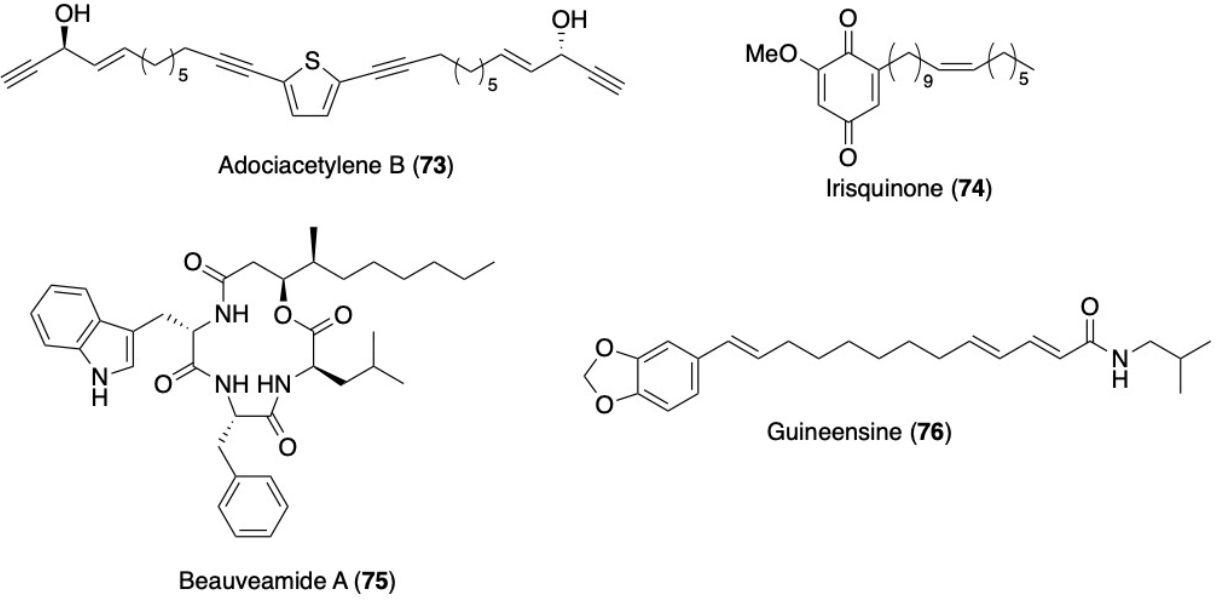
Figure 8. The structures of different classes that have all prepared with the alkyne zipper reaction as part of the synthesis.